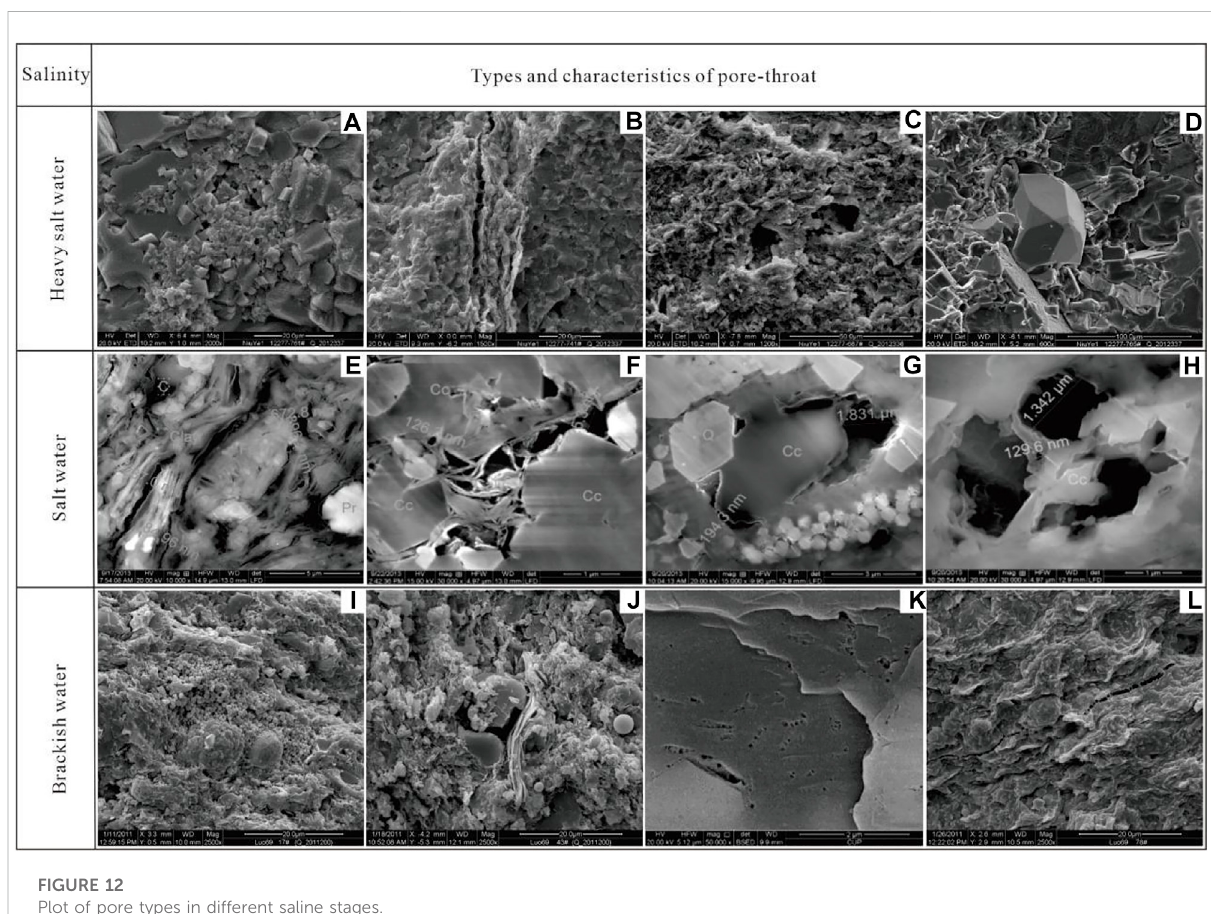
FIGURE 12 Plot of pore types in different saline stages.